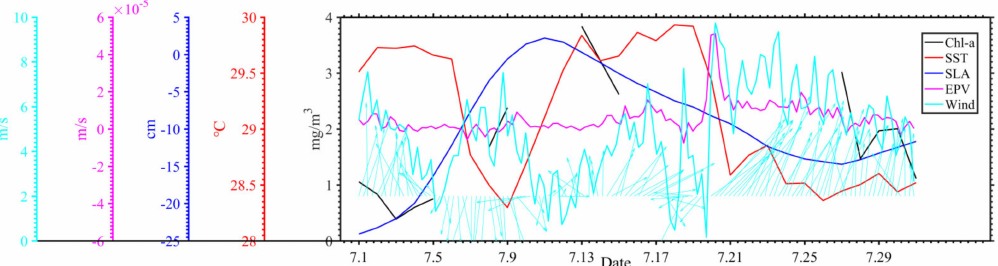
Figure 13. Time series of Chl- a concentration, sea surface temperature, sea level anomaly, Ekman pumping velocity and wind speed (vector) in the nearshore region of PRE mouth.